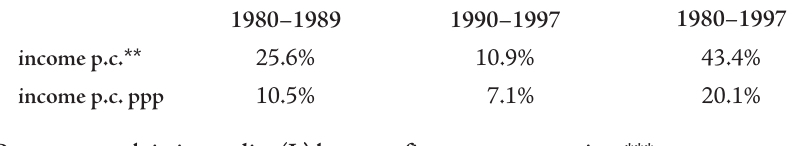
Table 2 – Change in world inequality – 103 countries and groups of countries* Percent growth in inequality (L) between 103 countries*